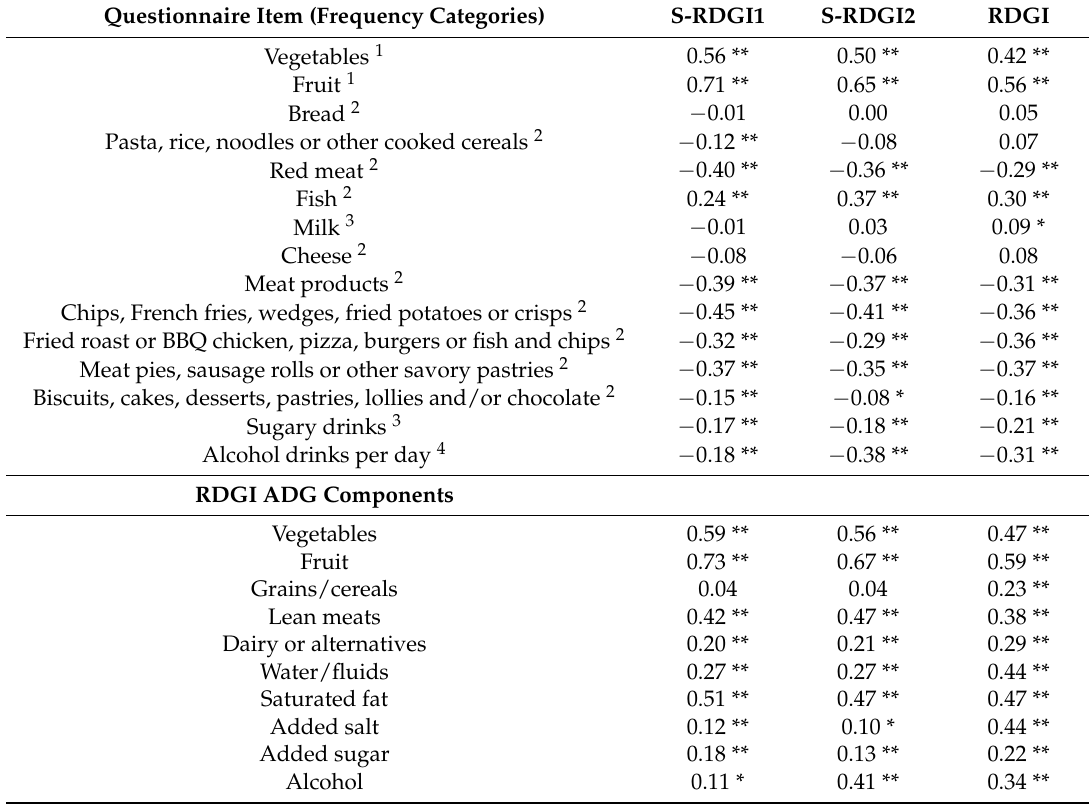
Table 4. Correlations between diet quality scores and intakes of food and drink items (based on original frequency categories outlined in Table A1) and Australian Dietary Guidelines (ADG) components (based on scoring outlined in Table